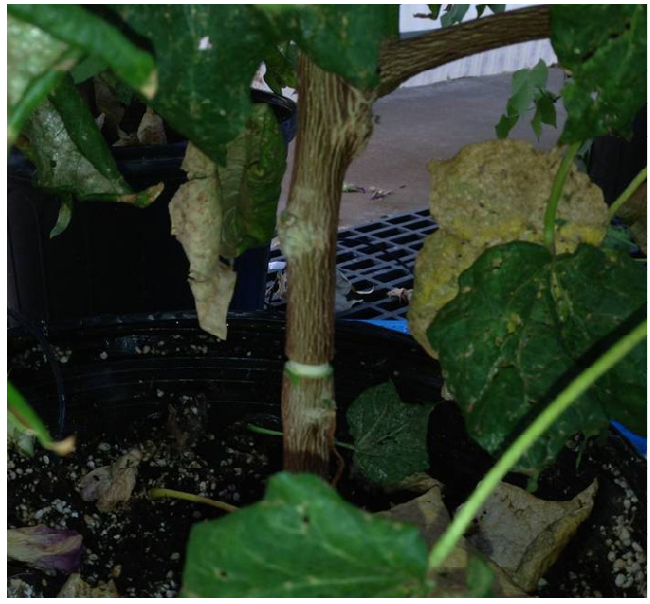
Figure 1. Cotton main stem hand knife girdling utilized to promote chemical ‐ free defoliation.